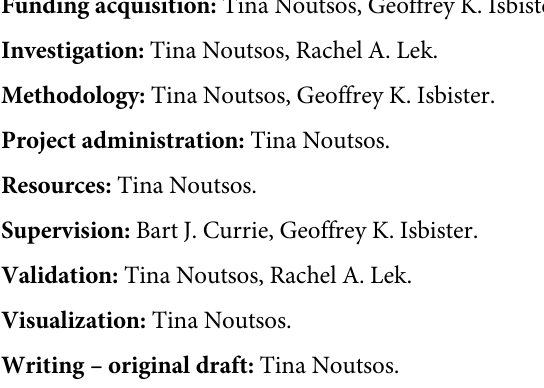
S6 Table. Reviewer judgements about risk of bias for included studies. (PDF) S7 Table. Histology findings for included cases: Renal biopsies and autopsies. (PDF) S8 Table. Dialysis free survival for patients with AKI requiring dialysis, for studies with a low risk of selection bias reporting intervention with plasmapheresis. S9 Table. Reviewer agreement—Cohen’s kappa statistic for selection of included studies and data extraction for outcomes and